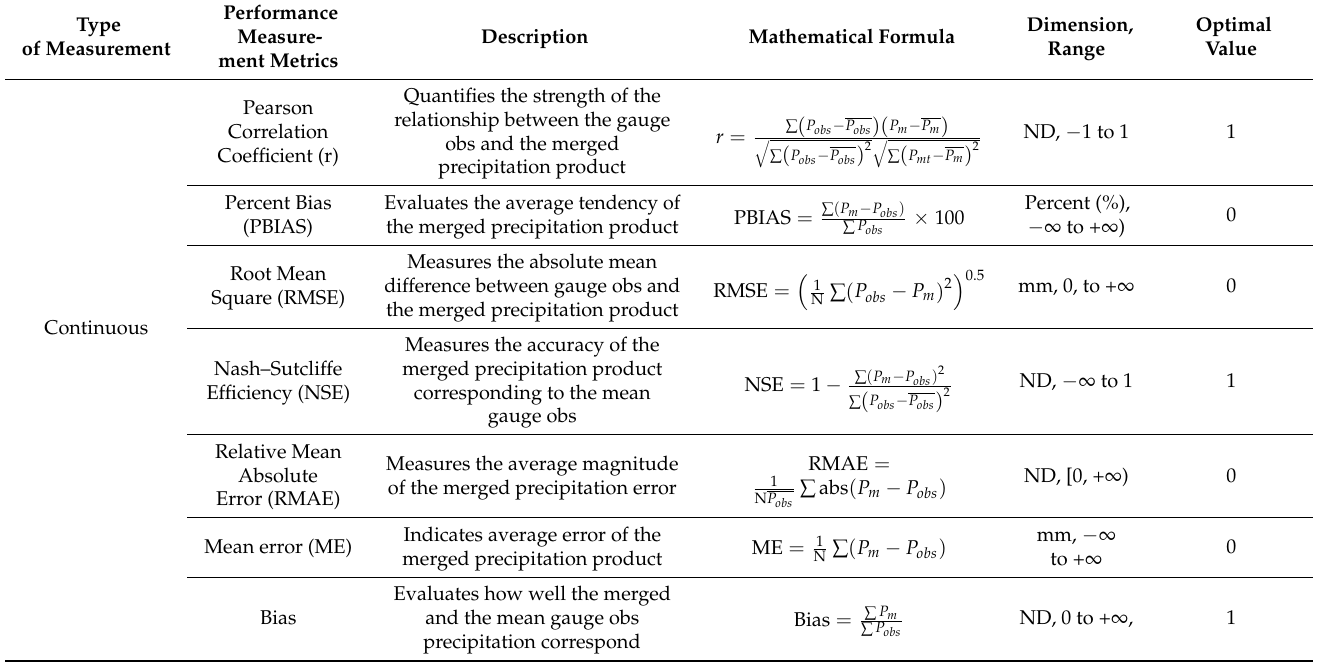
Table 2. A summary of continuous and categorical performance measurement